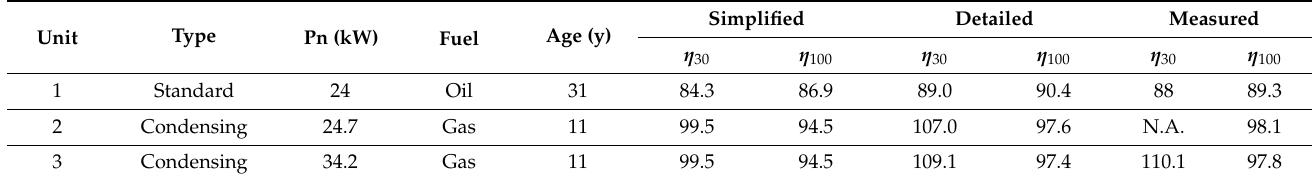
Table 3. Laboratory test compared with the model.